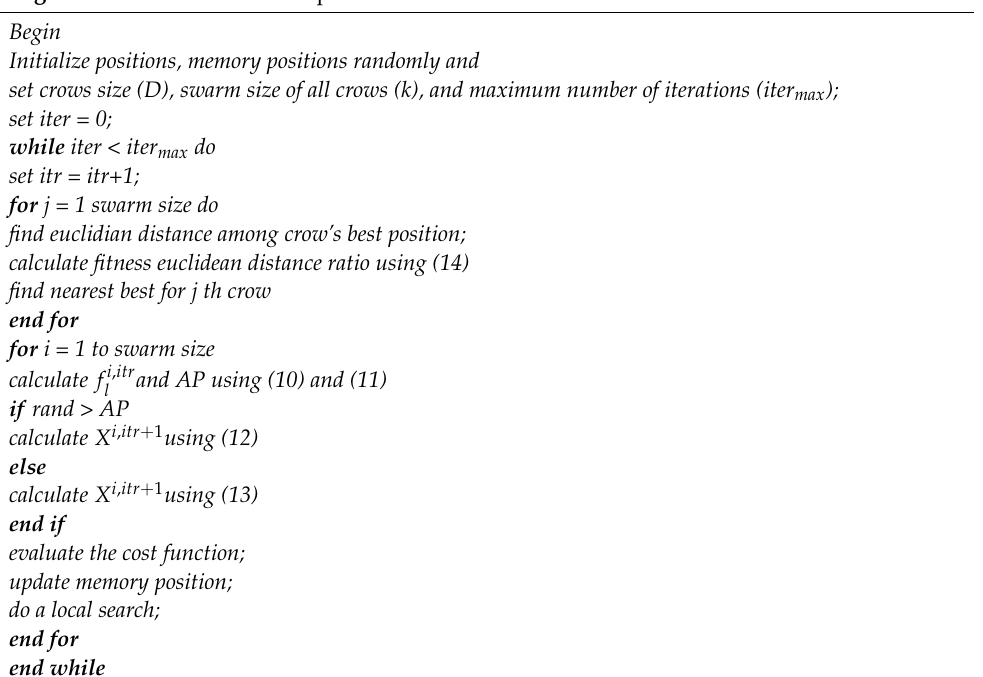
Algorithm 1 Pseudo Code: Proposed